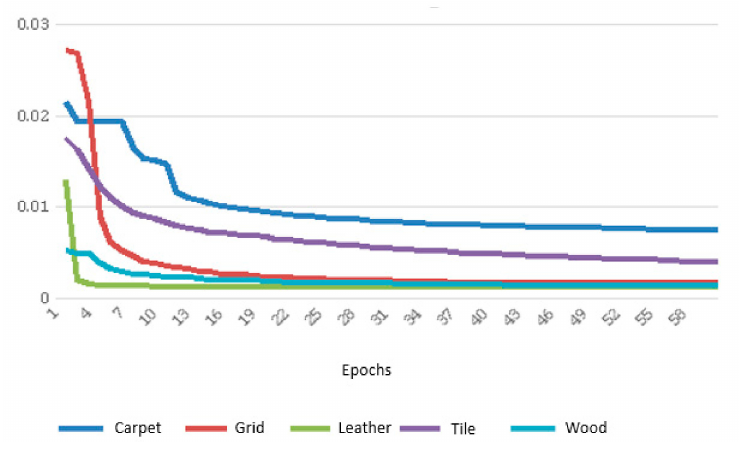
Figure 7. Evolution of the training loss.